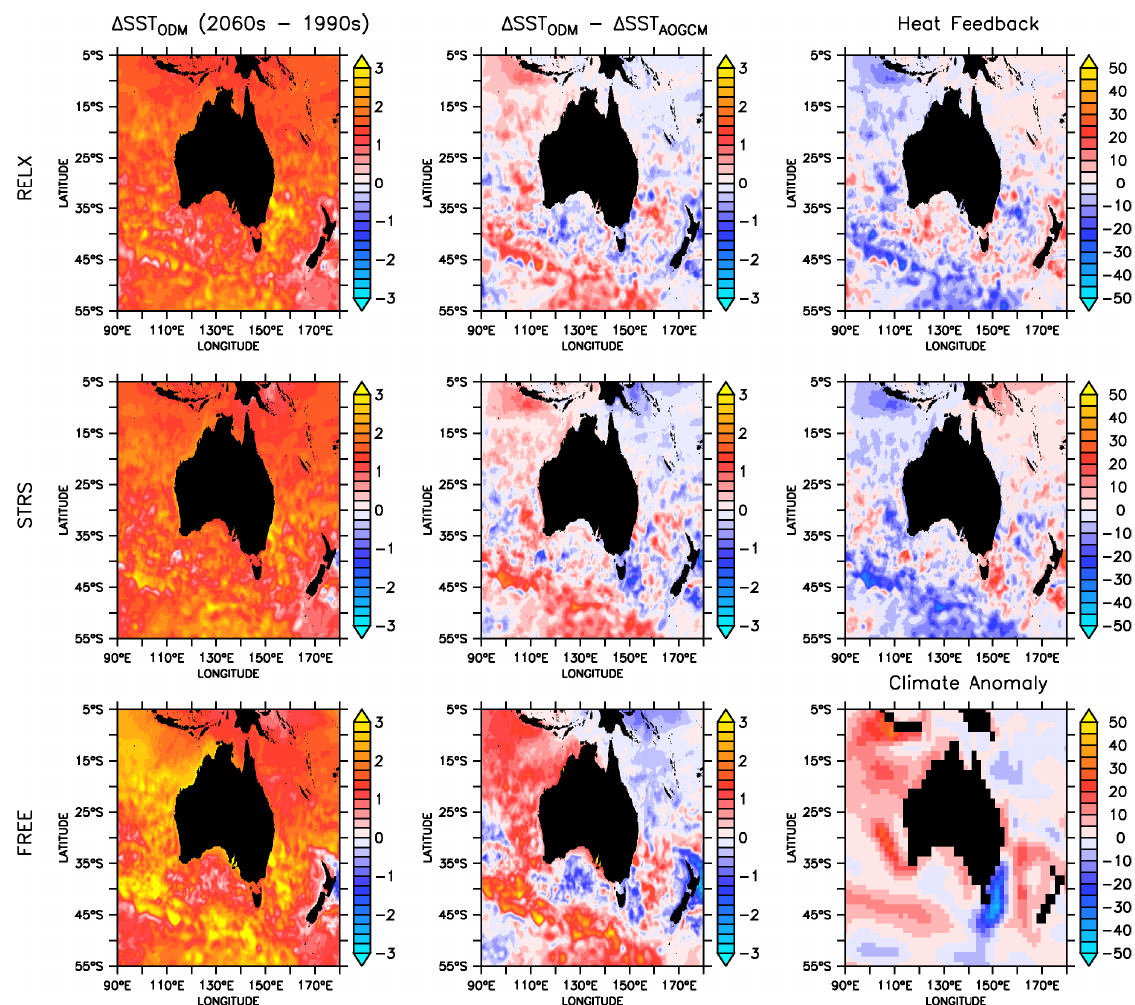
Fig. 9. Annual averages of: projected climate change in SST from the ODM (left column, in ◦ C), differences in climate change for SST (centre, ◦ C), and heat flux feedback (right, Wm − 2 ). For comparison, the average climate change heat flux anomaly is shown in the bottom right panel. The RELX experiment is shown along the top, STRS is in the middle, and FREE is at the